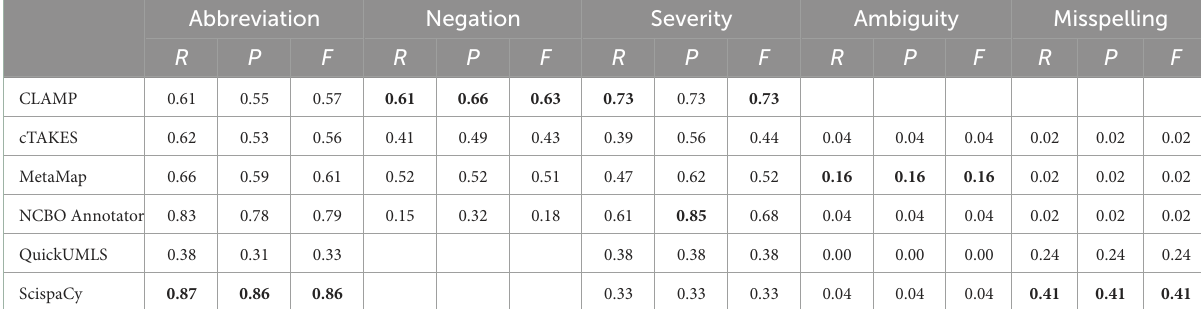
TABLE 5 Clinical concept recognition system performance on exact match at extracting five challenges from